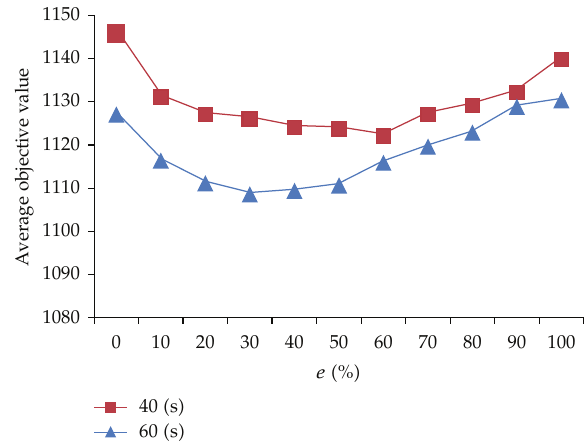
Figure 6: The influence of parameter e .